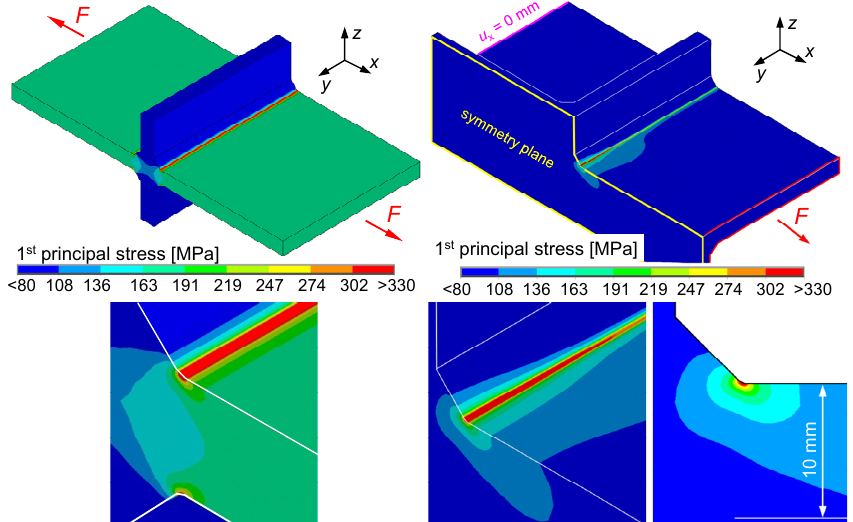
Figure 2: Calculated stress distribution at the transverse attachment (left) and the complex structure